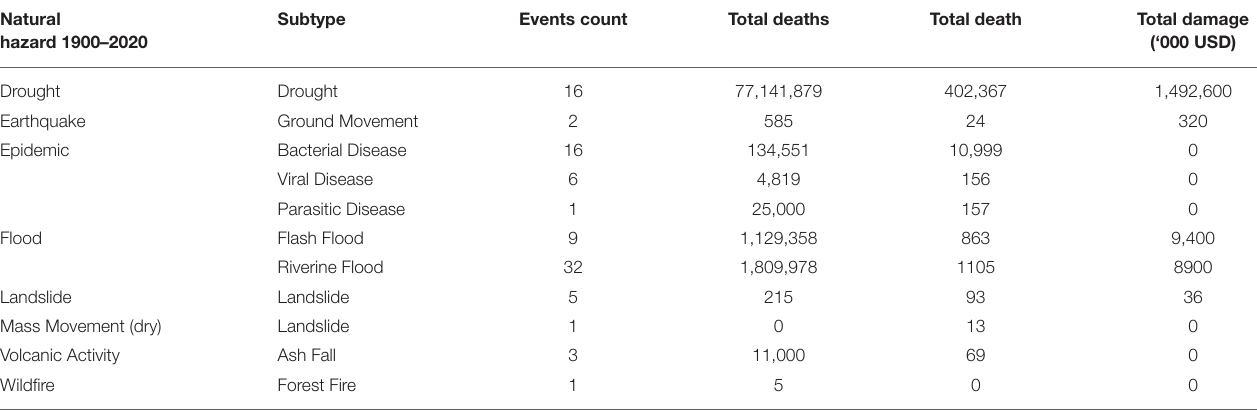
TABLE 3 | Natural disasters in Ethiopia,